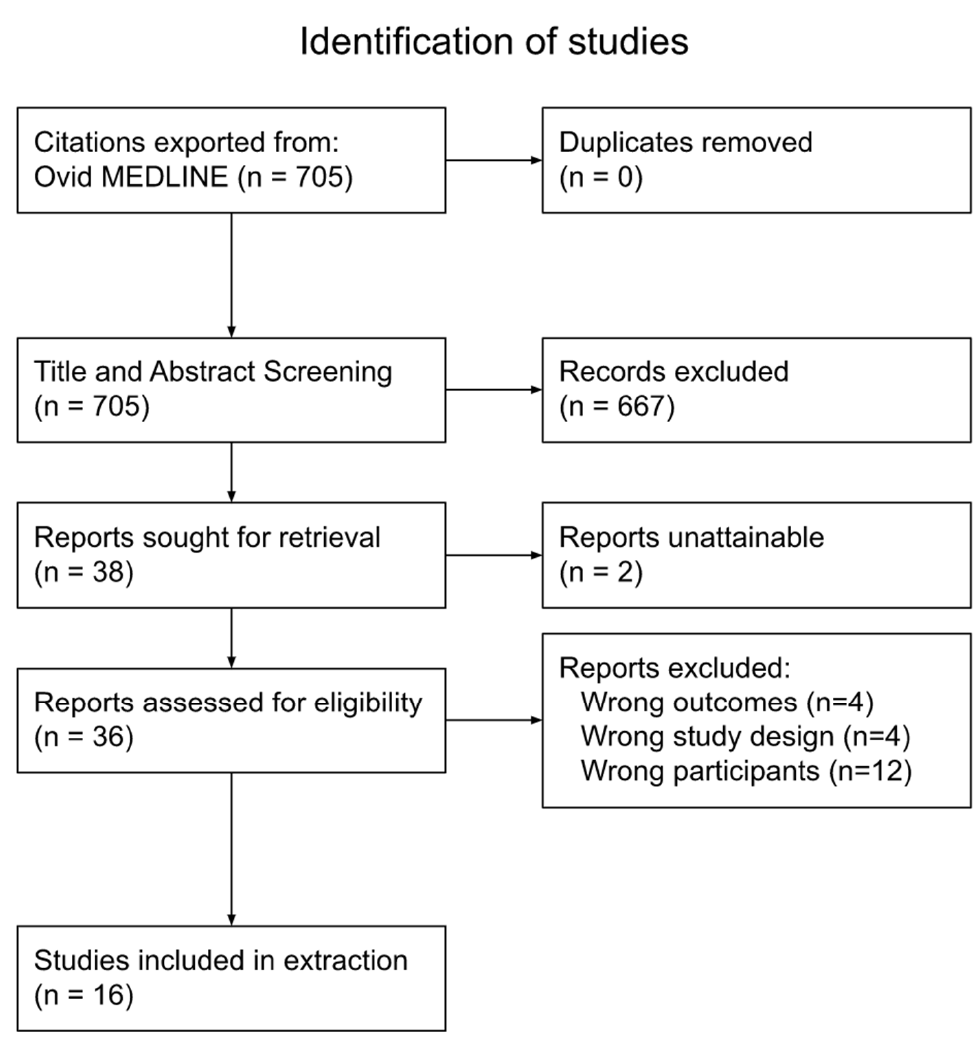
Figure 1. PRISMA-ScR diagram .